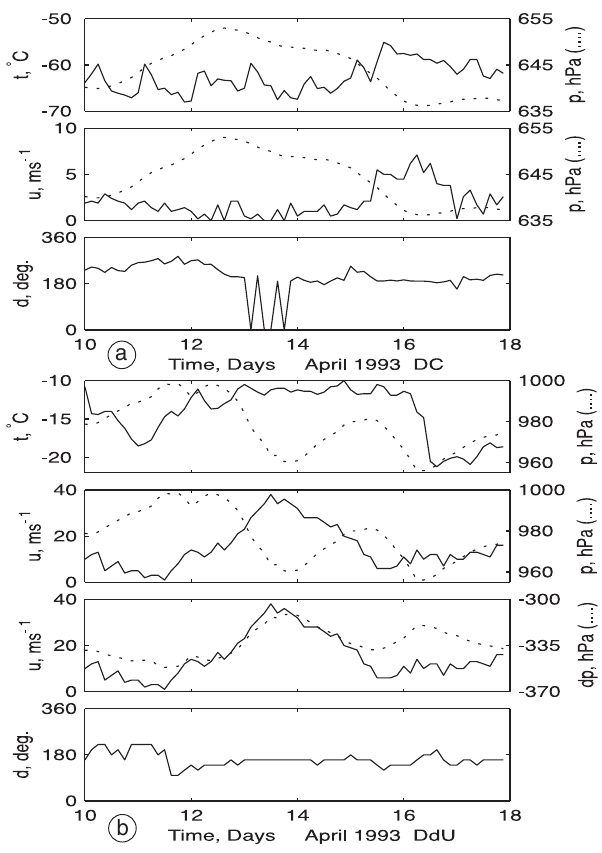
Fig. 2a,b. Time series of meteorological parameters: a) for Dome C; b) for Dumont d’Urville. The fi gure shows a strong wind event at DdU from 12 to 15 April